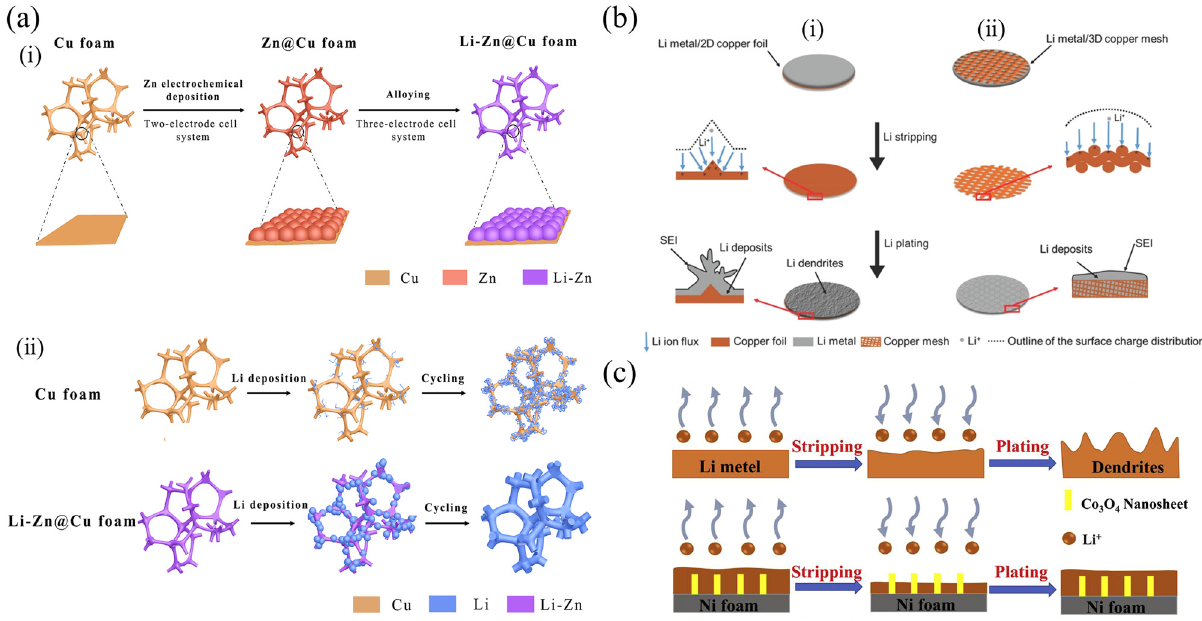
Figure 3: ( a ) Schematic diagram of ( i ) the fabrication for 3D Li – Zn@Cu foam, and ( ii ) Li depositing stage on substrates of Cu foam and 3D Li – Zn@Cu foam, reprinted with permission from ref. [ 26 ] ; ( b ) schematic diagrams of the stripping - plating process of ( i ) the bare Li metal/2D copper fi lm and ( ii ) Li metal/3D copper mesh, reprinted with permission from ref. [ 27 ] ; ( c ) bare Li anode and Li – Co 3 O 4 /NF composite anode, reprinted with permission from ref. [ 28 ]